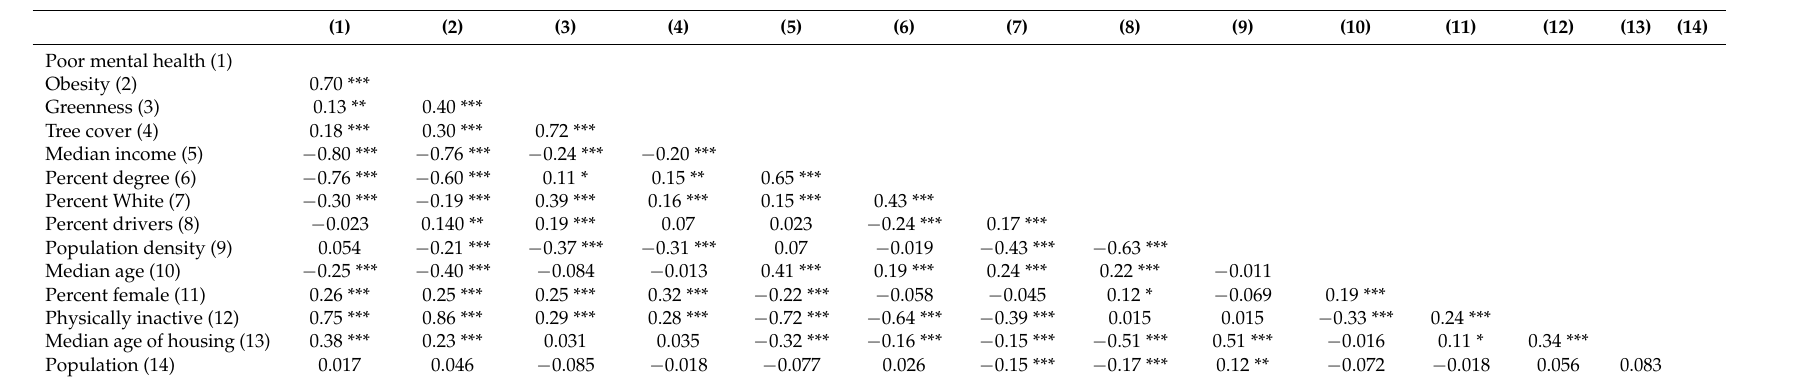
Table 3. Bivariate